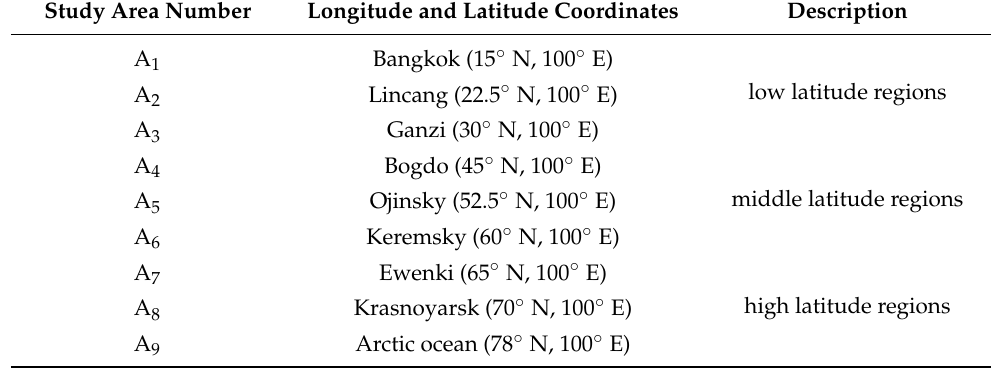
Table 1. Description of all the locations in this paper.